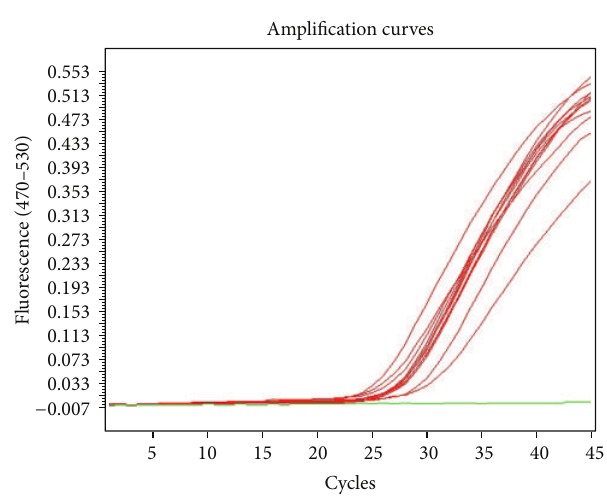
Figure 2: Application curves for shoot tip